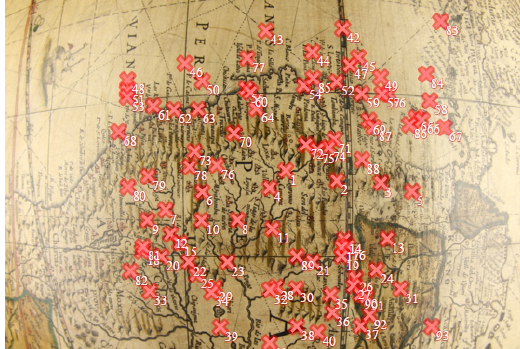
Figure 3. Automatically determined tie